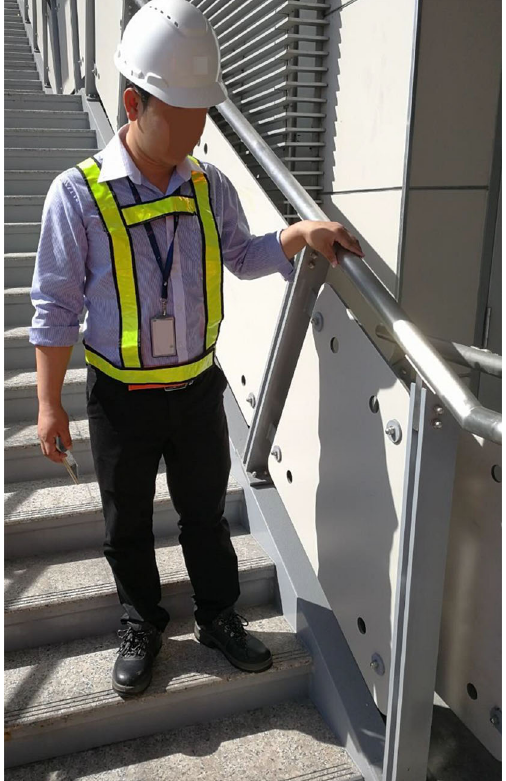
Fig. 4 Design and construction of handrails at a height of 1220 mm with 50-mm tubing due to misinterpretation of design standards, posing a hazard and increasing risks to children and the